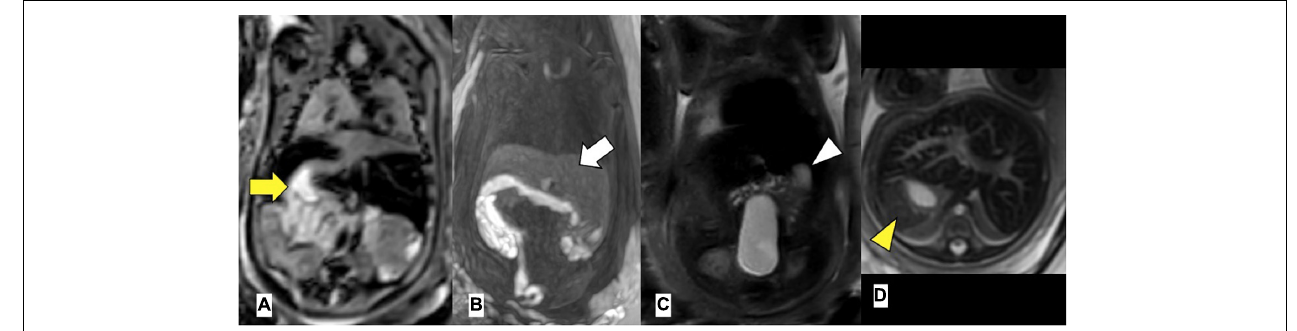
FIGURE 2 | Left atrial isomerism by foetal MRI. (A) Arrow yellow: right-sided stomach (B) arrow white: bilateral liver, (C) arrowhead white: left-sided gallbladder, (D) arrowhead yellow: left-sided spleen. Gestational age at MRI is 20 weeks + 0 day.